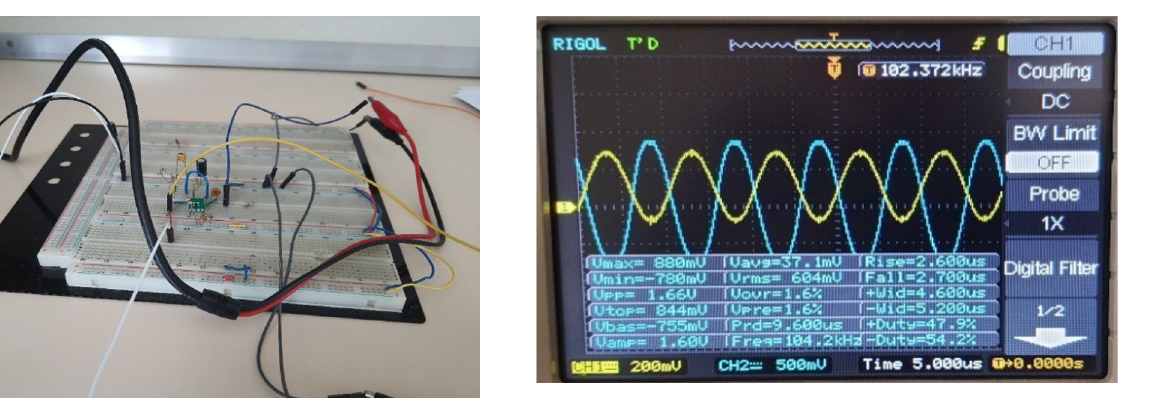
Fig. 5 Breadboard prototype of the common-source amplifier